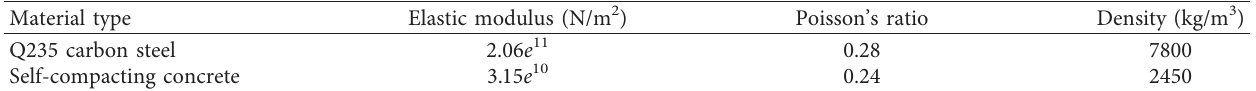
Table 1: Material parameters.